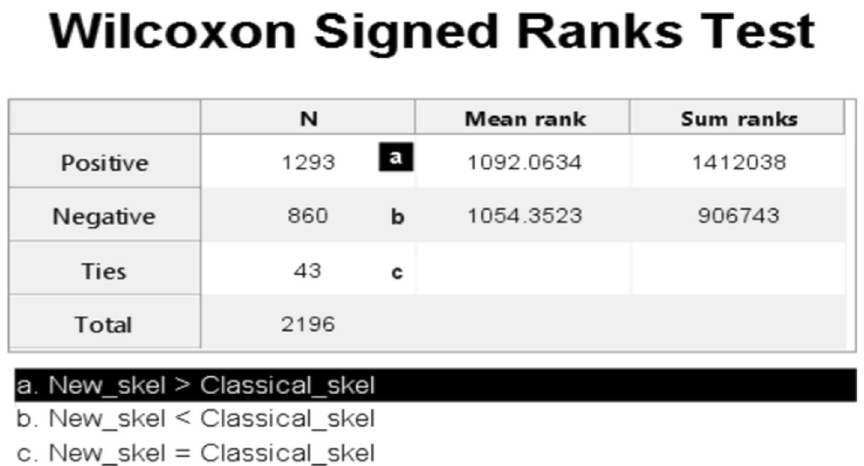
Figure 10. Wilcoxon Signed Ranks Test for the mean-IoU data in Table 1. The graph obtained from the Wilcoxon Signed Ranks test using the Statistics and Machine Learning Toolbox of Matlab2018b. Statistical toolbox indicated a higher positive range value than the negative range value. The p value of this test was 1.998E−18 less than the significance value. We can thus conclude that a statistically significant difference appeared between both methods, and the proposed method (New_skel) achieved major improvement compared to the classic method (classical_skel).